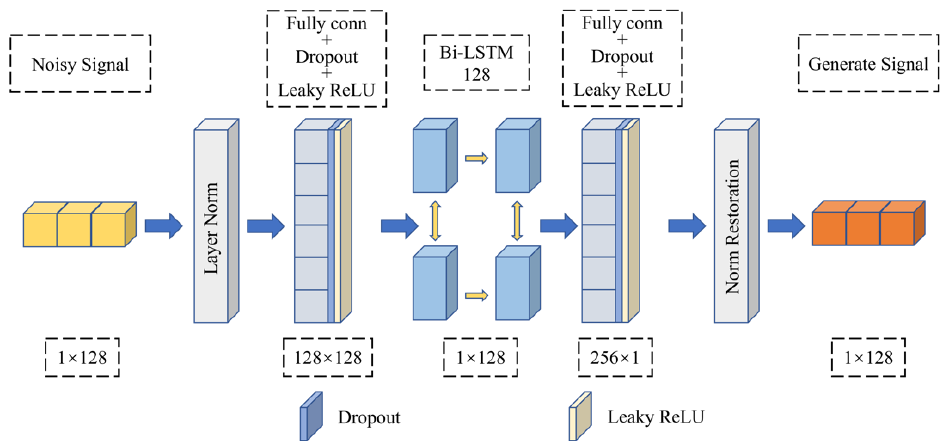
Figure 3. Generator network structure.